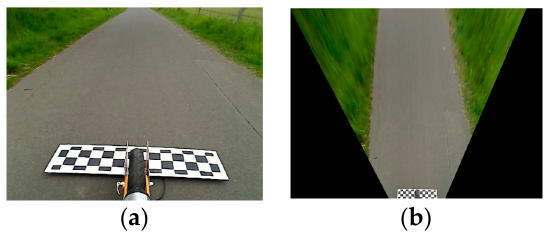
Figure 6. Inverse perspective mapping. ( a ) Original image; ( b ) Image after IPM transformation. To obtain the IPM image, the camera intrinsic and extrinsic parameters are required to perform this transformation. The intrinsic parameters represent a projective transformation from the 3-D camera’s coordinates into the 2-D image coordinates. The extrinsic parameters represent a rigid transformation from the 3-D world coordinate system to the 3-D camera’s coordinate system. These parameters represent the rotation matrix and translation matrix between points in the camera’s coordinate system and world coordinate system.